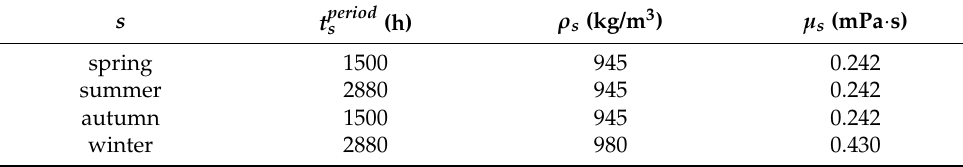
Table 3. The period-related data.